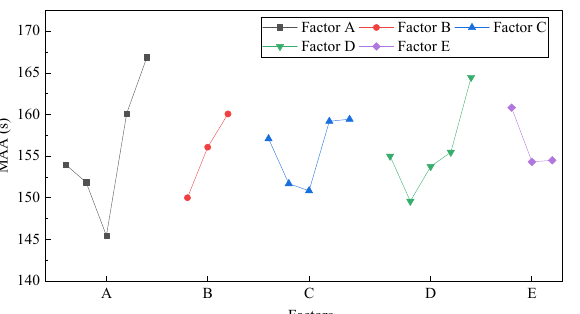
Figure 6. Relationship between factors and MAA in the single-heading tunnel (Each point on the curves represents a reasonable level of that factor, and the order is shown in Section 2.2.2). In terms of D o&h (Factor A), as the D o&h increases, the MAA overall increases. This is due to the increased spacing, which significantly increases the flow distance of air, which in turn leads to an increase in motion time; at the same time, when the airflow pressure drop is constant, the increase in distance will cause the heading face to be outside the effective distance of the airflow, causing the airflow to rotate more and more intensely at the heading face, as shown in Figure 7, which also increases MAA. The increase in Tu in